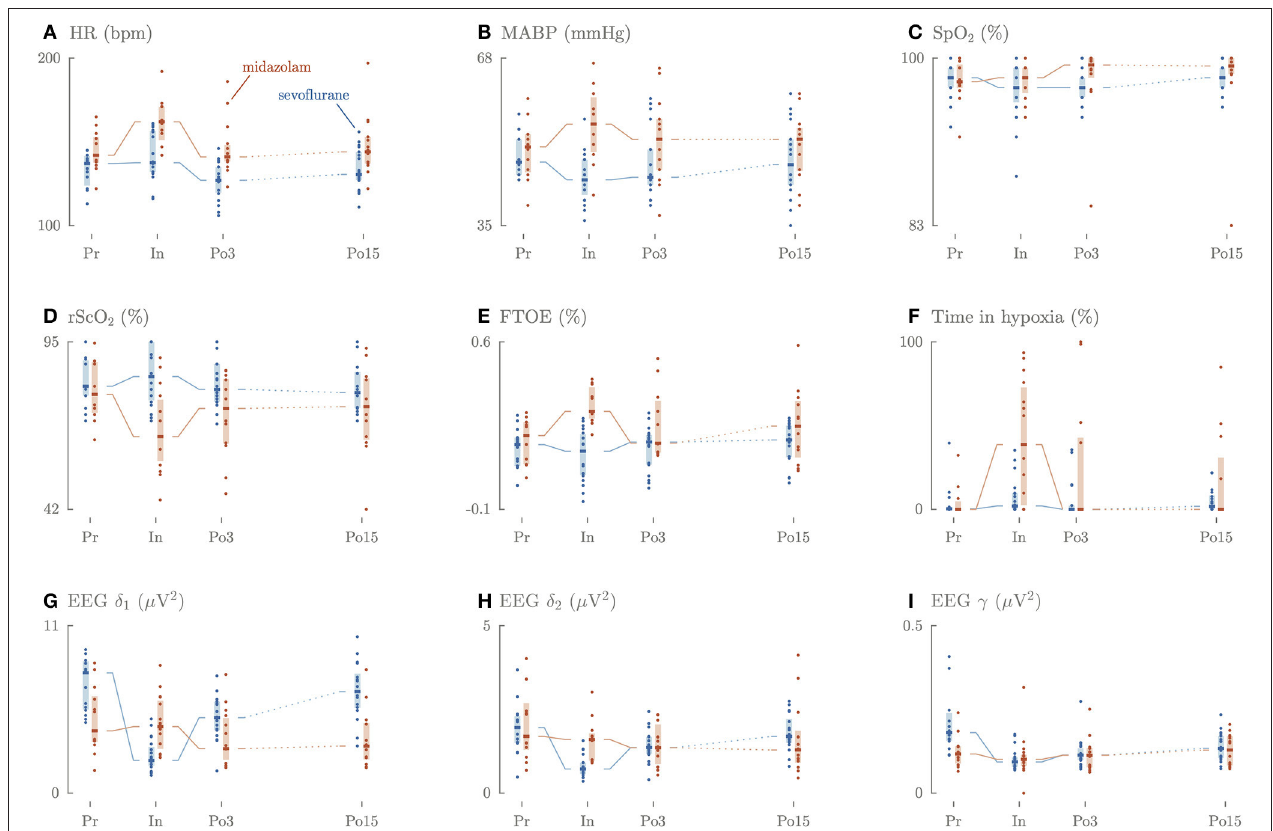
FIGURE 1 | Longitudinal overview of the perioperative changes in HR (A) , MABP (B) , SpO 2 (C) , rSO 2 (D) , FTOE (E) , time in hypoxia (F) , slow delta (G) , fast delta (H) , gamma (I) power.